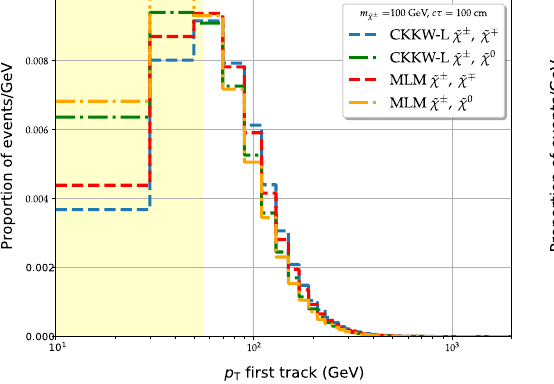
Thedistributionusesparticle-levelinformationbeforeanydetectorcon- siderations,soisindependentofdecaylength.Notshownistheoverflow bin, which contains negligible